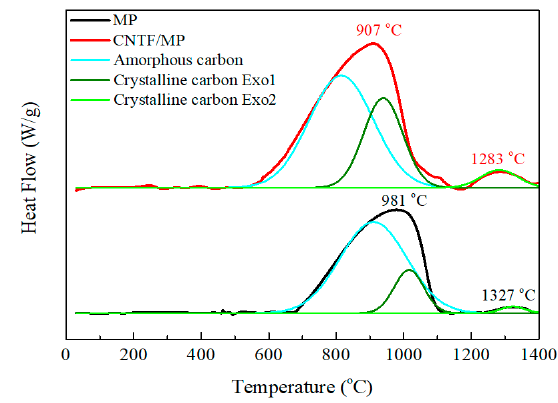
Figure 8. XRD patterns of CNTF/MPC@1000 and CNTF/MPC@1000